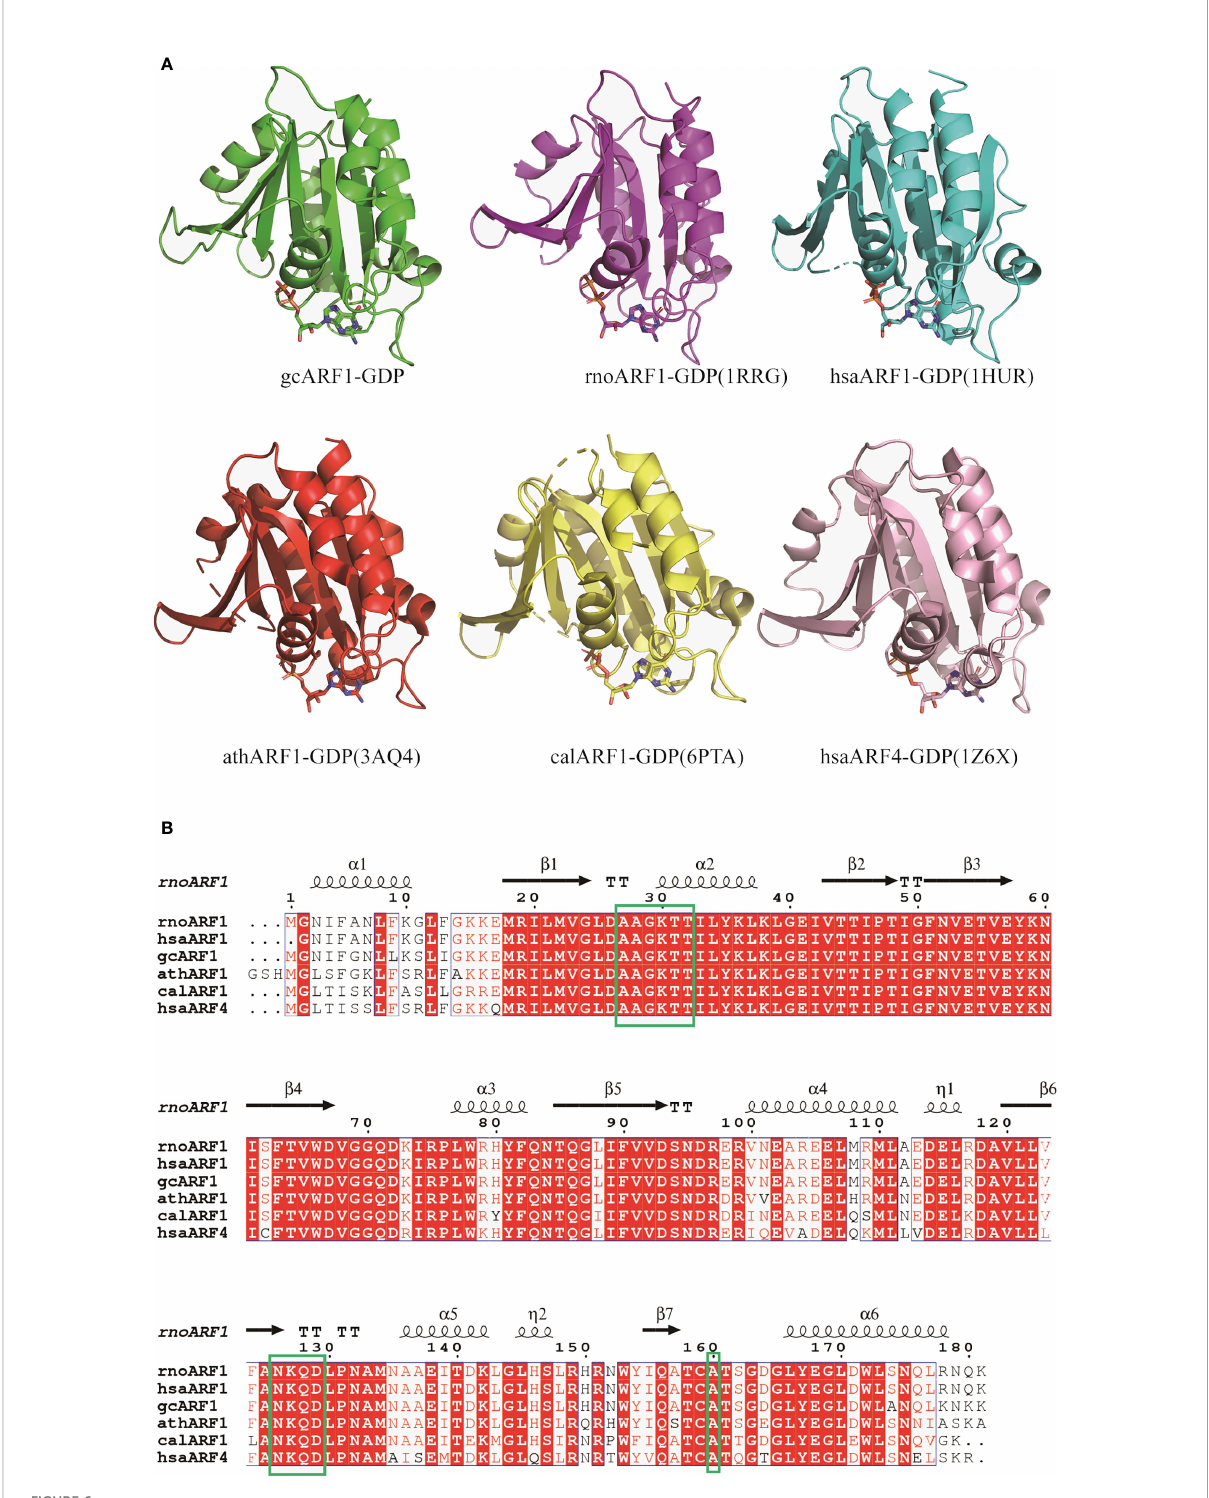
FIGURE 6 Structure and sequence alignments of gcARF1-GDP and ARF-GDP from other species. (A) Structure alignments of gcARF1-GDP (green), Rattus norvegicus ARF1-GDP (PDB code: 1RRG, purple, RMSD = 0.5), Homo sapiens ARF1-GDP (PDB code: 1HUR, cyan, RMSD = 0.6), Arabidopsis thaliana ARF1-GDP (PDB code 3AQ4, red, RMSD = 0.8), Candida albicans SC5314 ARF1-GDP (PDB code: 6PTA, yellow, RMSD = 0.7) and Homo sapiens ARF4-GDP (PDB code: 1Z6X, pink, RMSD = 1.1). (B) Sequence alignments of gcARF1 and ARF proteins from other species by Clustal W and ESPript